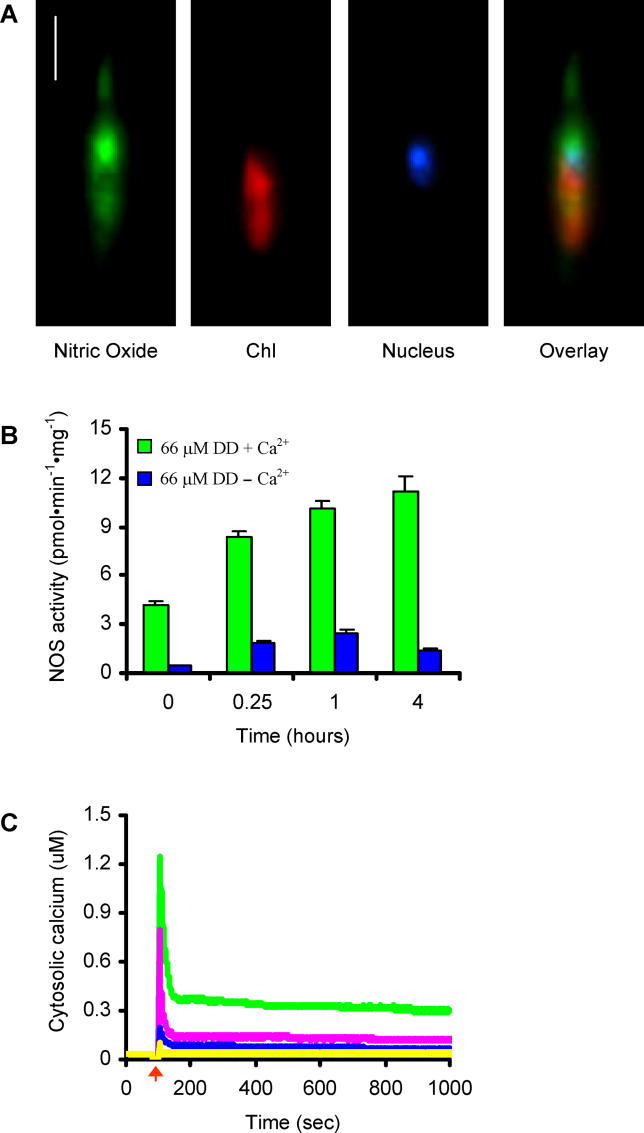
The Origin of NO in P. tricornutum and Its Interplay with Calcium(A) Intracellular localization of DAF-FM-derived fluorescence (green) compared with DAPI-staining (blue) and chlorophyll (Chl) autofluorescence (red) in P. tricornutum.(B) NOS enzymatic activity in cell-free extracts induced by DD (66 μM [10 μg/ml]), in the presence or absence of calcium.(C) Ca2+ transients in response to addition of 1, 3, and 5 μg/ml (6.6, 19.8, and 33 μM) DD, depicted in blue, pink, and green respectively and of 10 μg/ml (65 μM) (2E)-decenal (yellow) in transgenic P. tricornutum cells expressing the calcium-sensitive photoprotein Aequorin. Addition is indicated by arrow. Data in (B) are means plus standard deviation from four experiments. Representative data from at least four experiments are shown in (A) and (C). Scale bar represents 5 μm.